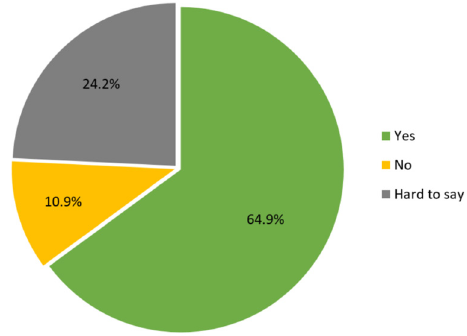
Fig. 8. Survey results chart of